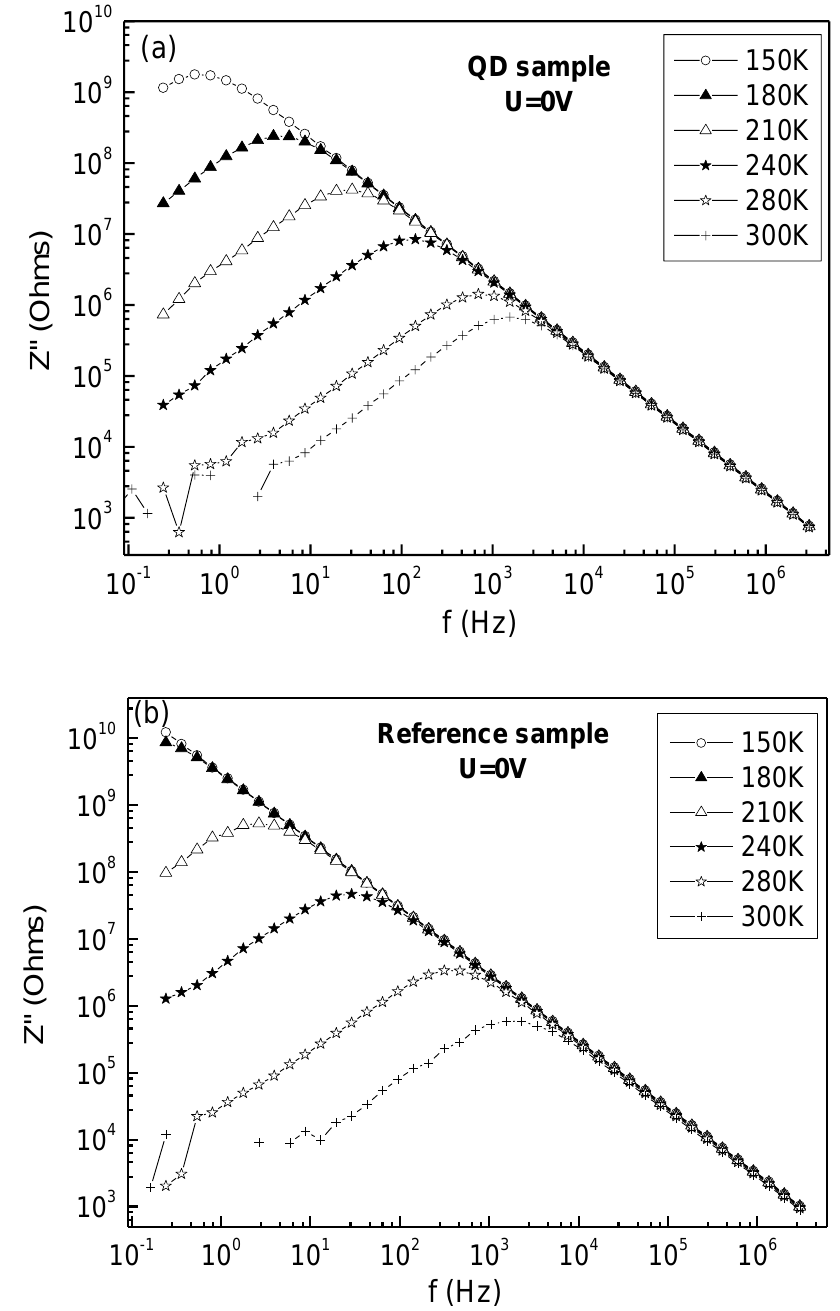
Figure 4. Double-logarithmic imaginary impedance versus frequency plots taken at different temperatures for the quantum dot ( a ) and reference samples ( b ). temperatures for the quantum dot ( a ) and reference samples ( b